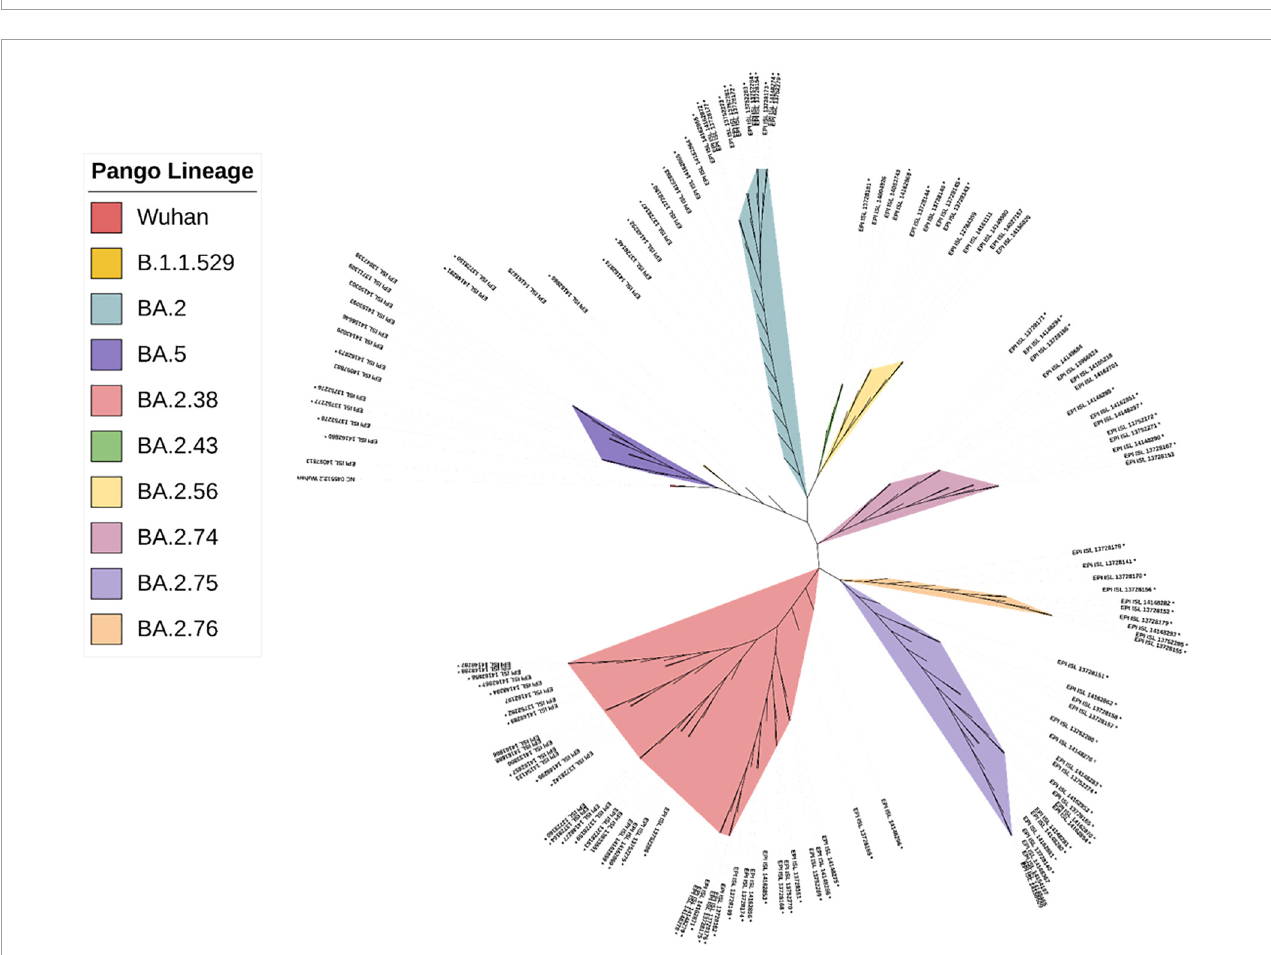
FIGURE2 The phylogenetic distribution of whole-genome sequences of 108 SARS-CoV-2 strains from Chhattisgarh, India, and 30 samples from elsewhere, with the reference sequence of the Wuhan strain.